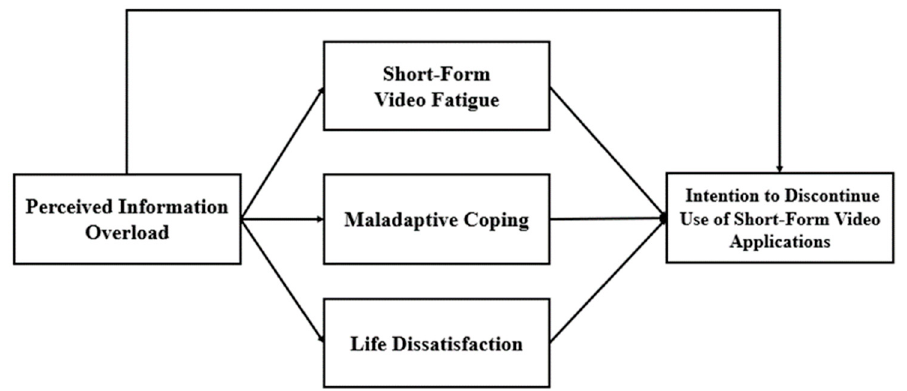
Figure 1. A model of the predictors of the intention to discontinue the use of short-form video ap-